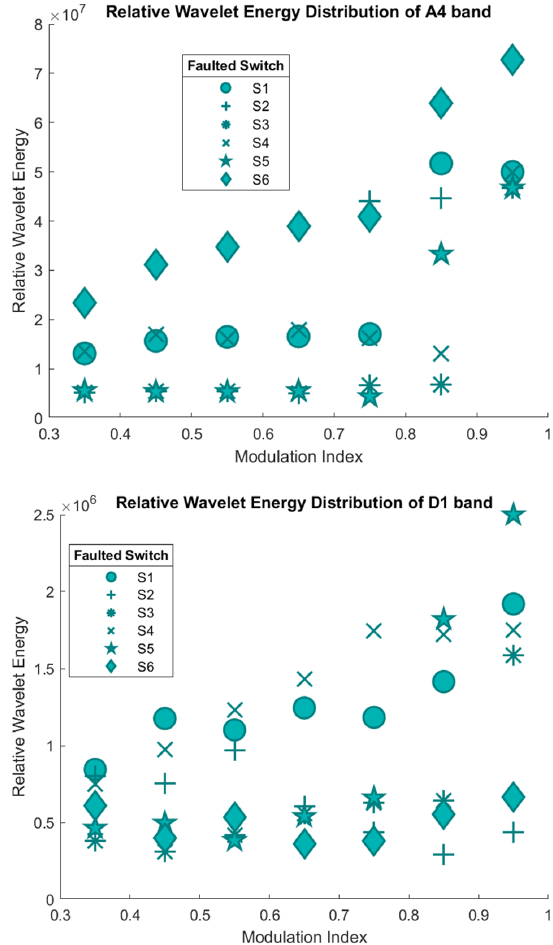
Figure 7. Wavelet energies of the A4 and D1 bands.